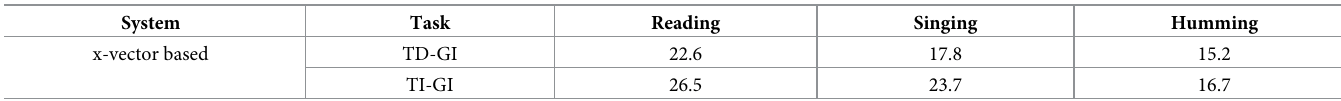
Table 8. EER% on the single-speaking styles TD-GI and TI-GI ASV tasks, using the whole RSH to train the x-vector extractor.